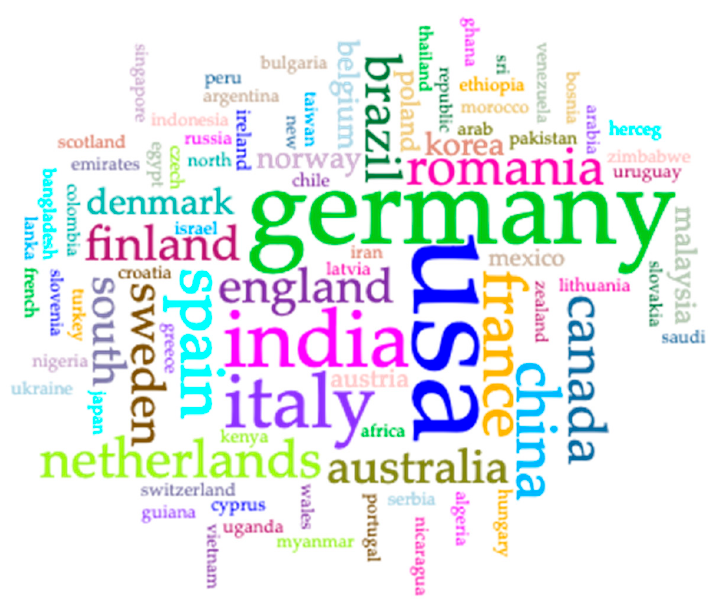
n = 790 articles, Gephi software).